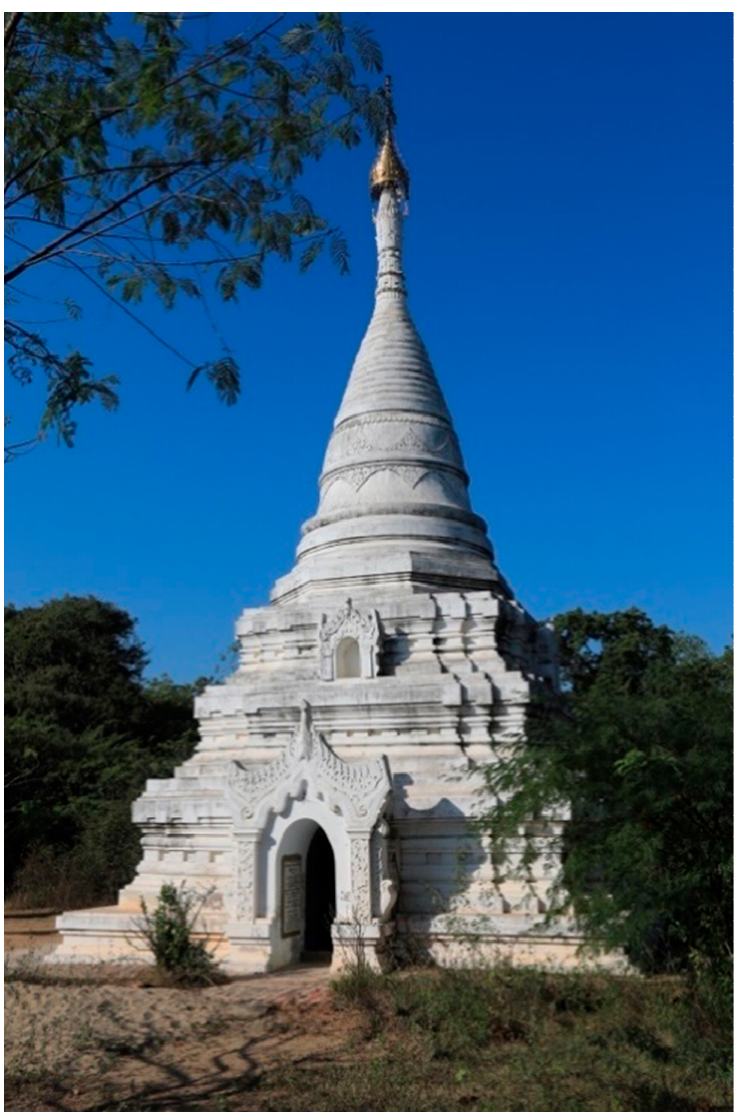
Figure 2. Salyingyi, 18th century—a typical medium sized endowment.